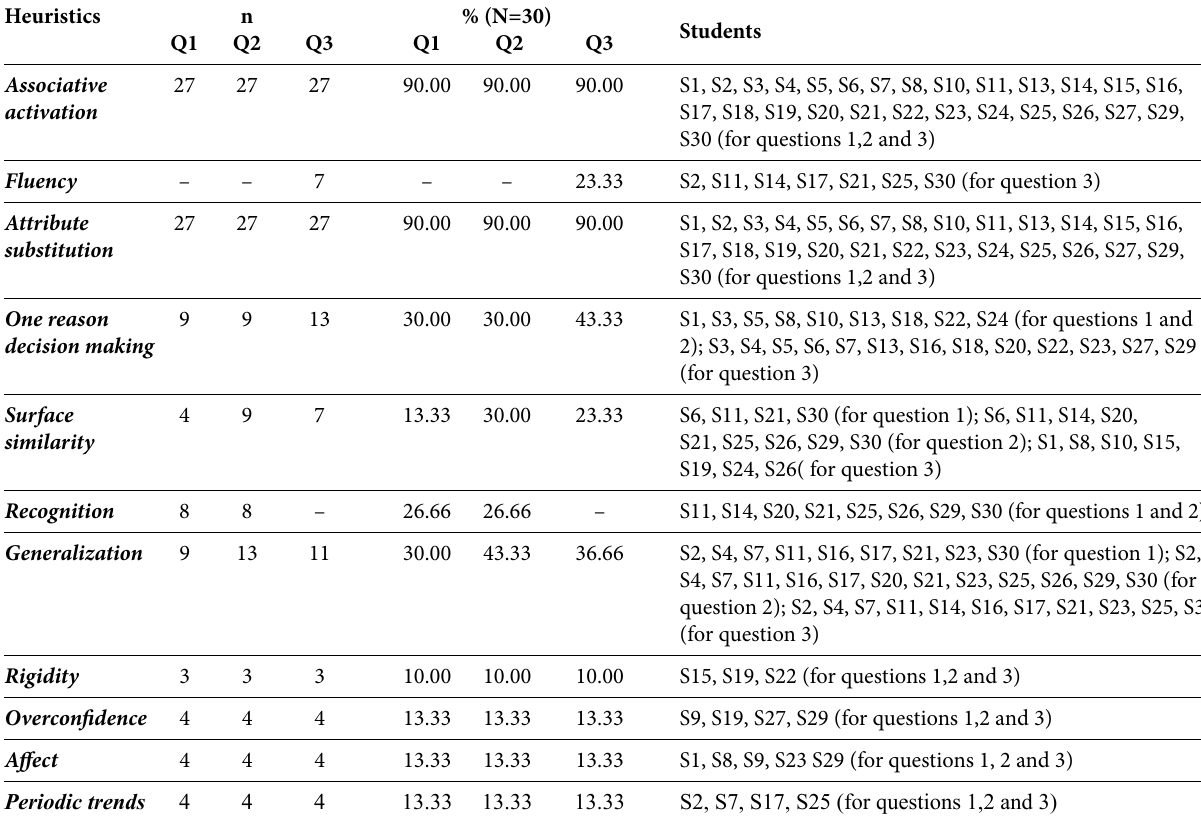
Table 3. The number and percentages of participants who have used relevant heuristics at least once